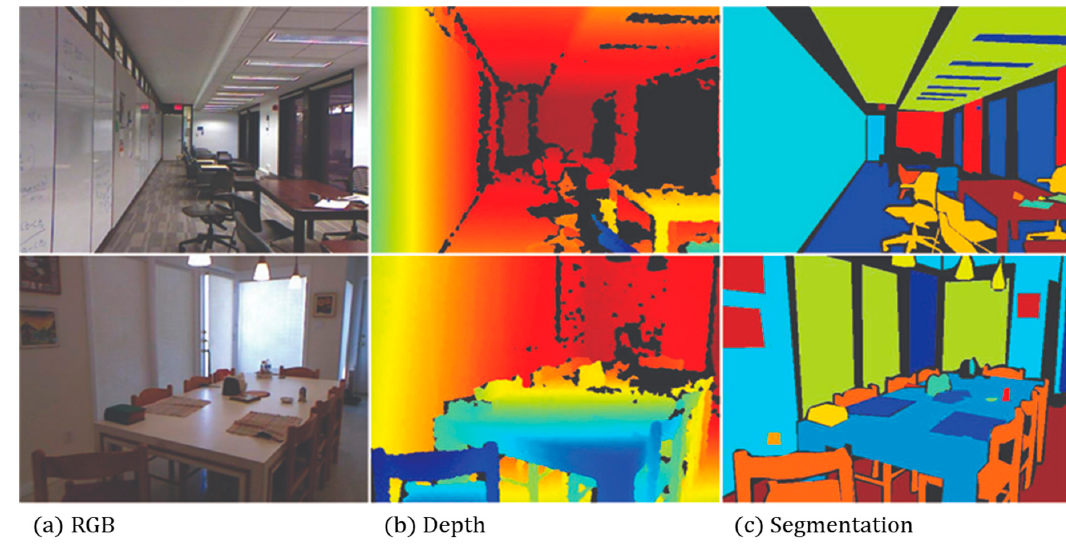
Figure 14. NYU Depth Dataset V2.